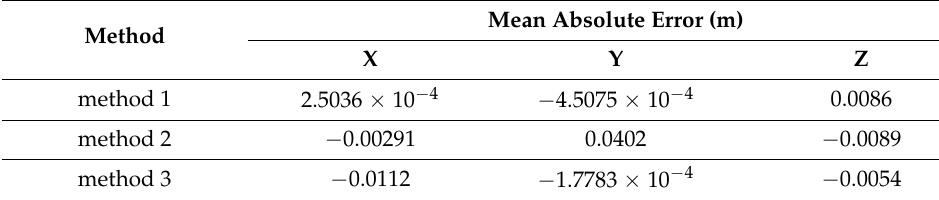
Table 2. RMSE of the localization results for each component. Method X Y method